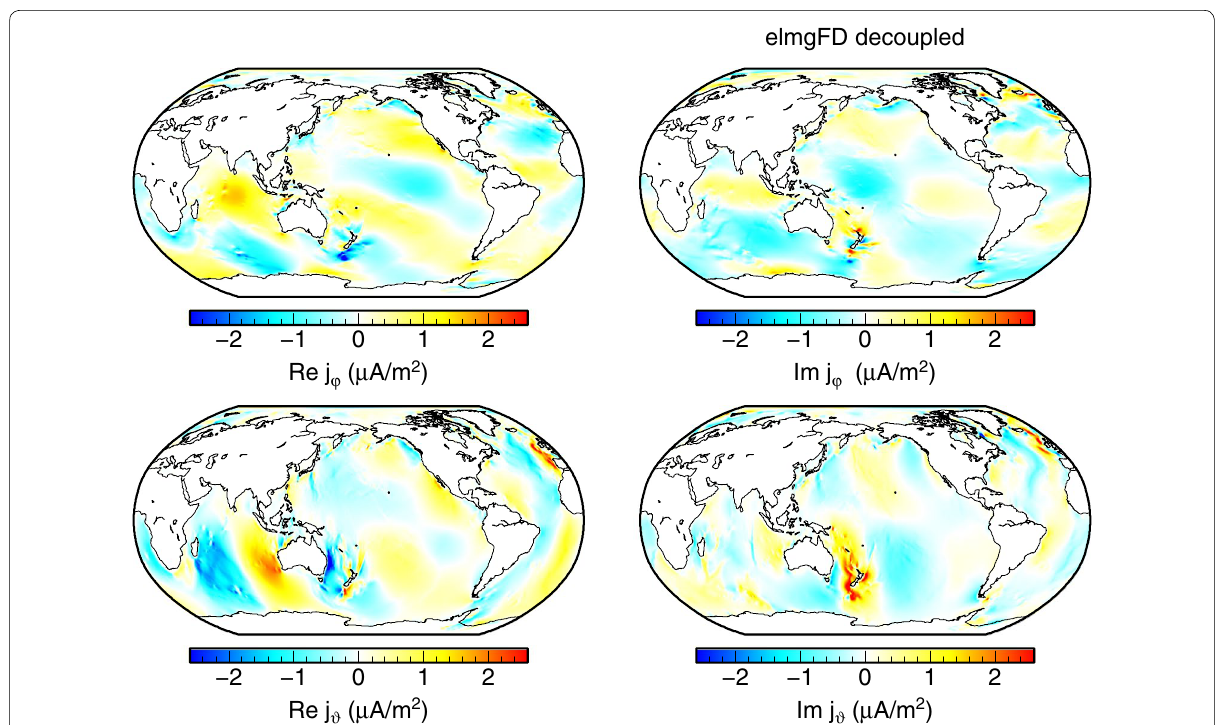
Fig. 12 Electric current density at the seafloor. The horizontal components obtained for the decoupled solution. The radial component is zero everywhere in this